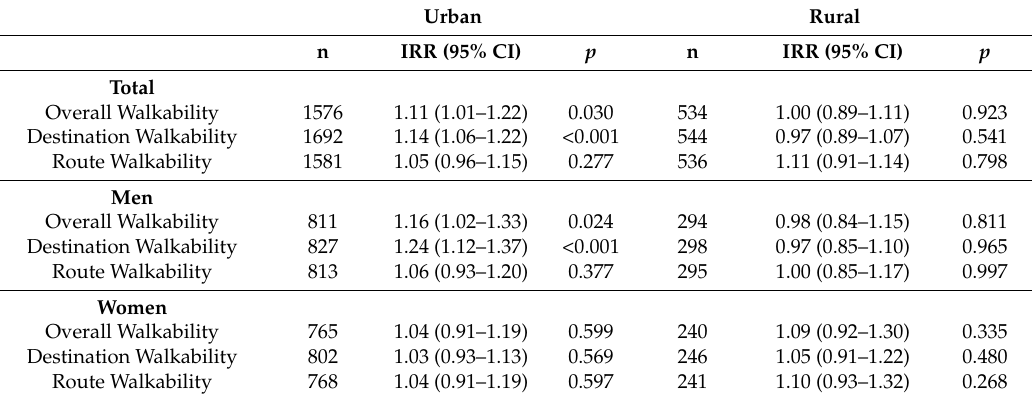
Table 4. Association between perception of walkability and walking frequency for urban and rural residents, for total sample and stratified by sex. Urban